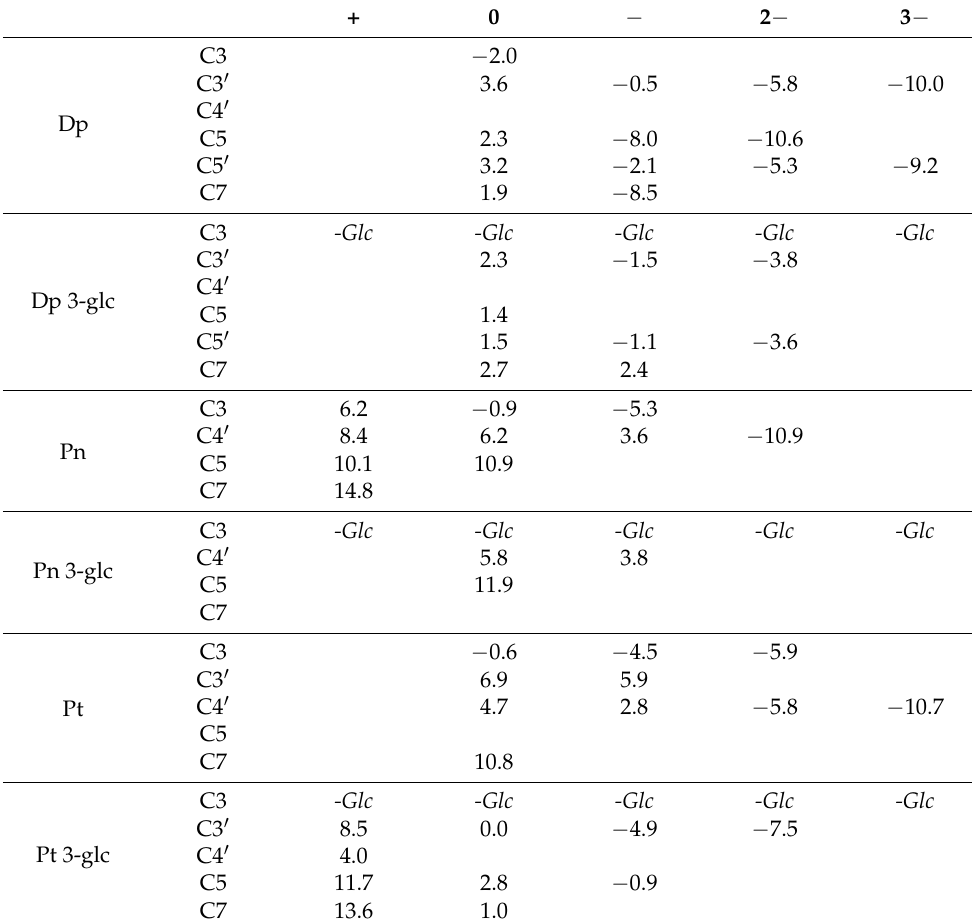
Table 4. Gibbs free energies (in kcal mol − 1 ) of f -HAT reactions between the anthocyanidins’ and anthocyanins’ species and DPPH • in water; the lowest values are bold typed.